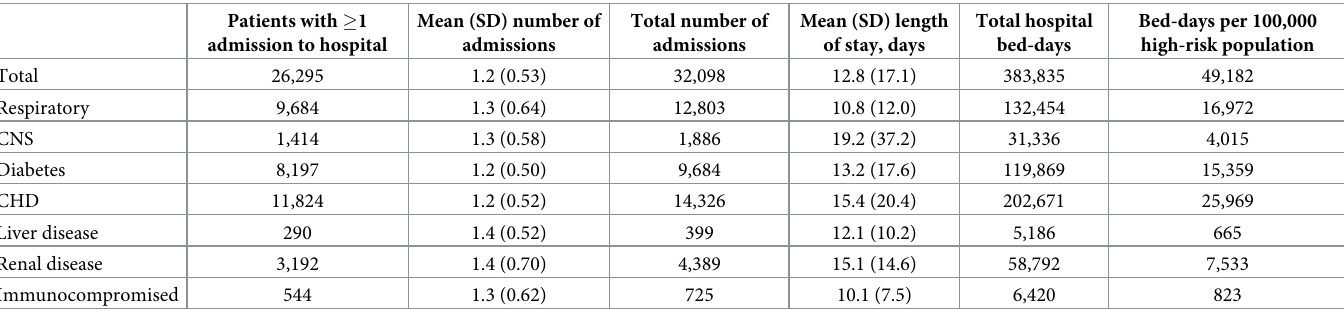
Table 5. Secondary care resource use for acute respiratory illness in high-risk patients extrapolated to the UK population for influenza seasons from 2001 to 2009. Patients with � 1 admission to